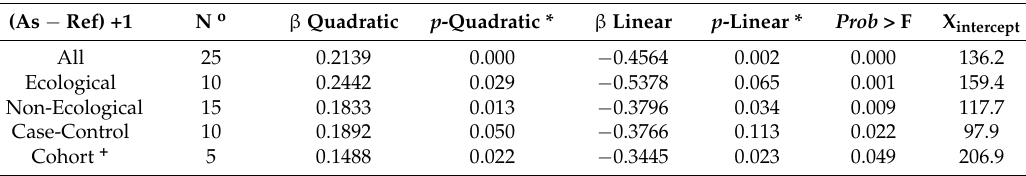
Table 2. Meta-regression results by study